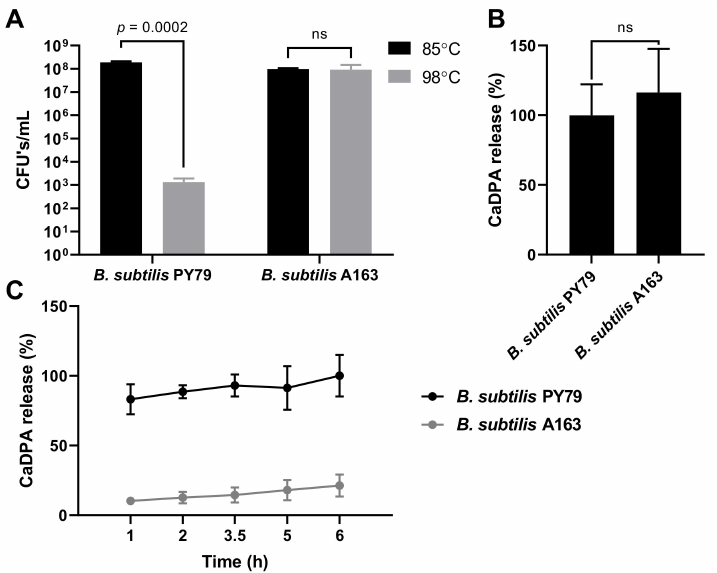
Figure 1. Heat resistance test and DPA content of B. subtilis spores. The standard deviation is shown in the graphs. Statistical significance was determined using Student’s t -test. ns, not significant.